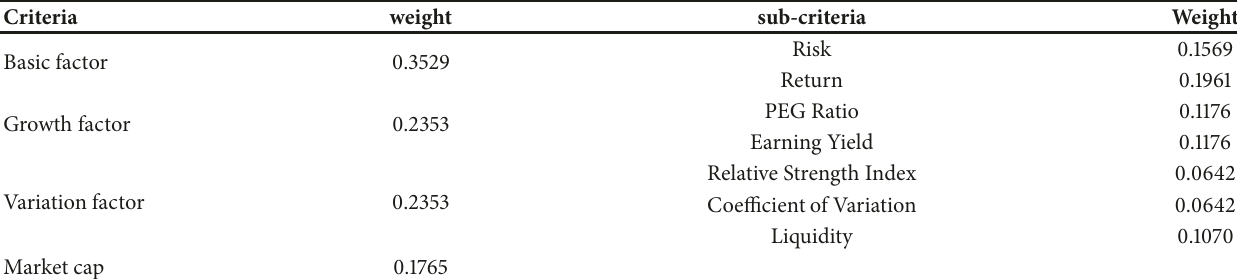
Table 3: Weight of criteria and subcriteria.